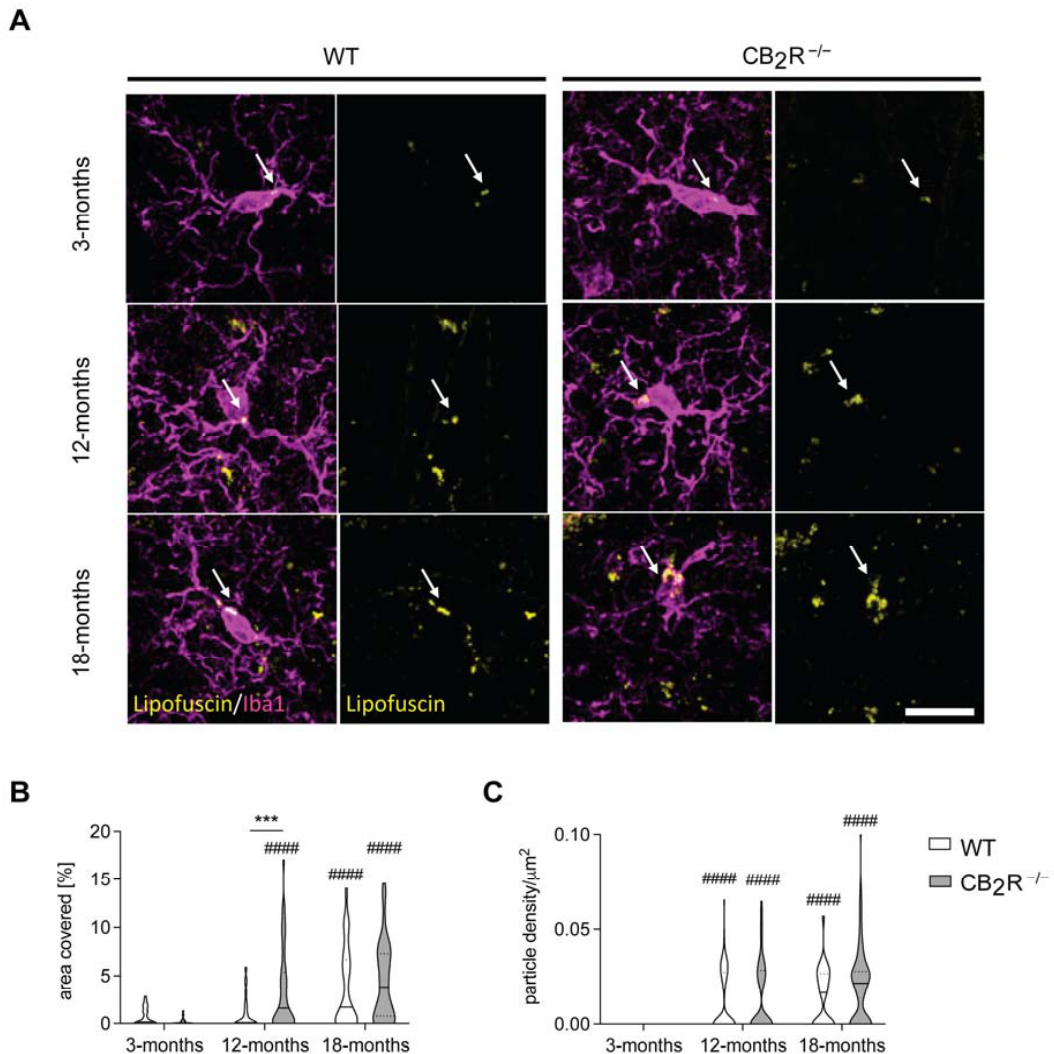
Figure 4. Accumulation of Lipofuscin in microglia is increased after CB2 deletion. Representative microscopy images of Lipofuscin accumulation in microglia in the stratum radiatum of the hippocampus. Scale bar represents 50 µ m ( A ). The microglial somatic area covered with lipofuscin ( B ) and the particle density ( C ) show a significant increase with age in both genotypes. Microglia from CB 2 R − / − mice show enhanced lipofuscin accumulation in comparison to WT mice, which resulted in an interaction effect. WT mice—white; CB 2 R − / − mice—grey. N = 6 mice/genotype/age group. Data displayed as median (full line) with 25 and 75 percentiles (dotted lines). Two-way ANOVA followed by Sidak’s multiple comparisons with *** p < 0.001 significance between genotypes within the same age group; #### p < 0.0001 significance in relation to 3-months old group within the same